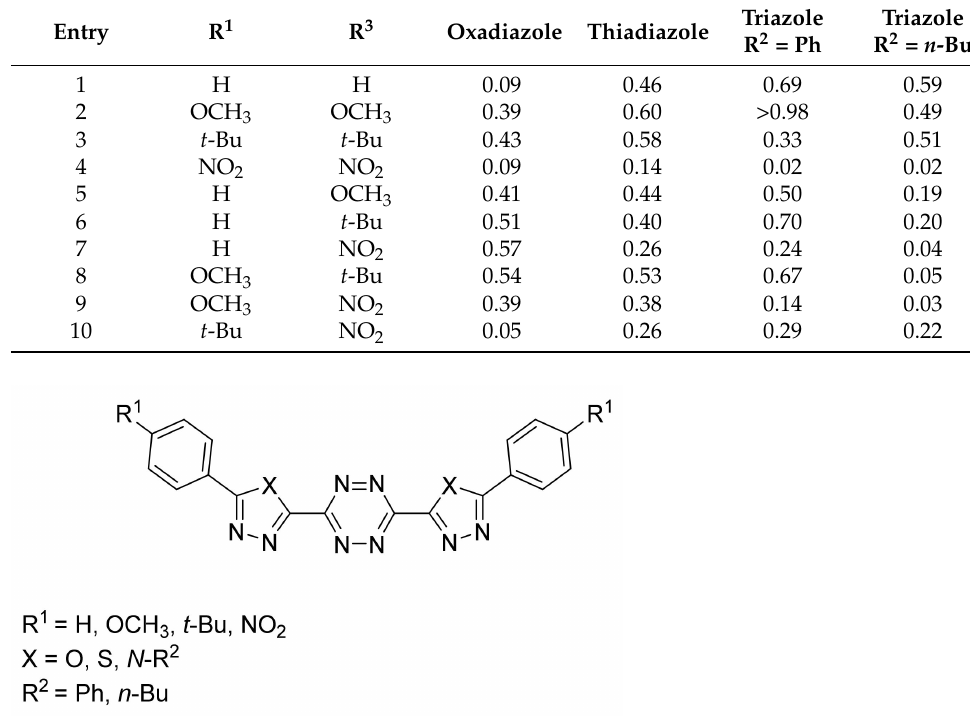
Table 4. Comparison of the quantum yields of s -tetrazine derivatives conjugated via phenylene linkers with oxadiazole [24], thiadiazole [25], and triazole rings (symmetrically substituted from [26], and unsymmetrically substituted from current